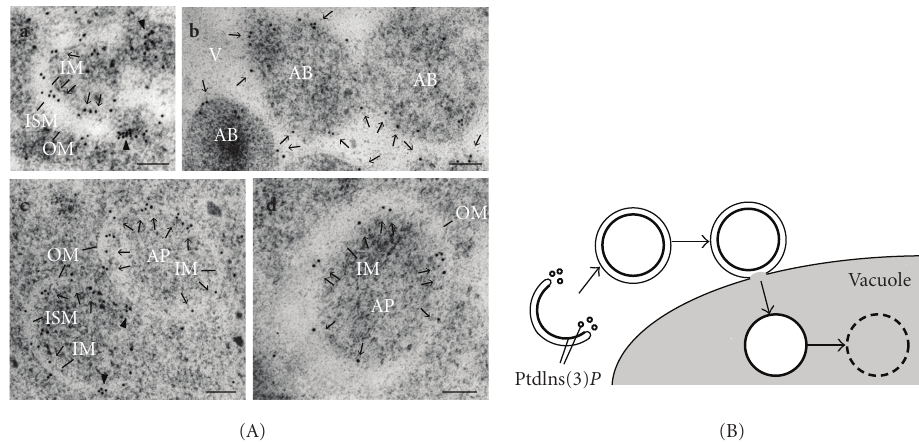
Figure 3: Dynamics of PtdIns(3) P during autophagy. (A) BJ2168 cells expressing mRFP-2xFYVE were cultured in nitrogen-depleted medium for 3.5h and then subjected to immunoelectron microscopy with an a ffi nity-purified anti-FYVE antibody. Gold particles on the inner membrane (IM) of the isolation membrane (ISM in (a) and (c)), the autophagosome (AP in (c) and (d)), and the autophagic body (AB in (b)) membranes are indicated by arrows. Arrowheads in (a) and (c) indicate gold particles near the tips of the isolation membranes. Ribosomes can be distinguished because they appear hazier than the gold particles. OM, outer membrane. V, vacuole. Bars, 100 nm. (B) Summary of the PtdIns(3) P dynamics during autophagy. PtdIns(3) P -enriched sites are shown in bold lines. Reproduced from [23] (Copyright 2008 by the Molecular Biology Society of Japan/Blackwell Publishing Ltd) and from [37] (Copyright 2008 by Landes Bioscience).